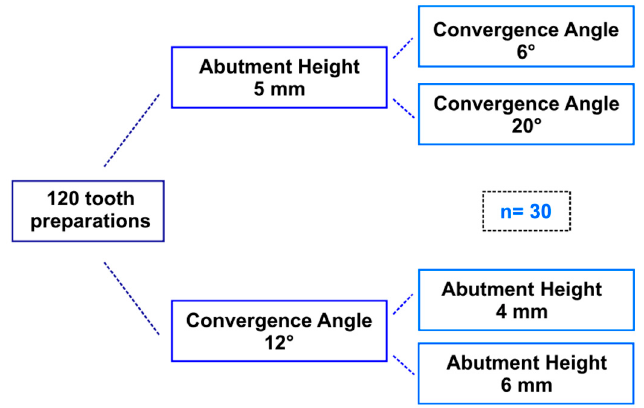
Figure 1. Schematic representation of the study design.